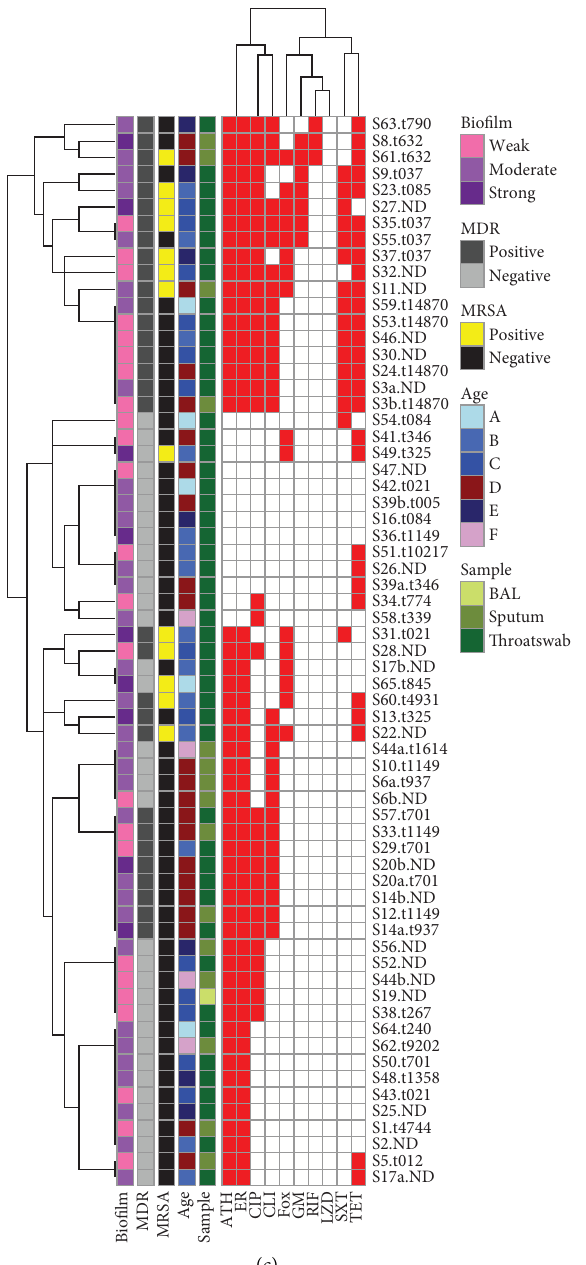
Figure 2: Population structure of S. aureus isolates. (a) Relative frequency of resistance to antibiotics in S. aureus isolates and bioflm formation status. (b) Relative frequency of MDR and non-MDR S. aureus isolates vs. age group. (c) Overview of antimicrobial-resistance profles and other characteristics of S. aureus isolates. ATH, azithromycin; ER, erythromycin; FOX, cefoxitin; RIF, rifampin; GM, gen- tamicin; CIP, ciprofoxacin; SXT, trimethoprim-sulfamethoxazole; CLI, clindamycin; TET, tetracycline; age group is represented as A < 2, B 2–5, C 6–10, D 11–15, E 16–20, F 20–30 years of age; spa types are shown in front of isolate code; S, S. aureus ; a and b letters represent the diferent morphotypes of the same bacteria isolated from the same patient; red squares are representative of resistance and white squares represent susceptibility to the tested